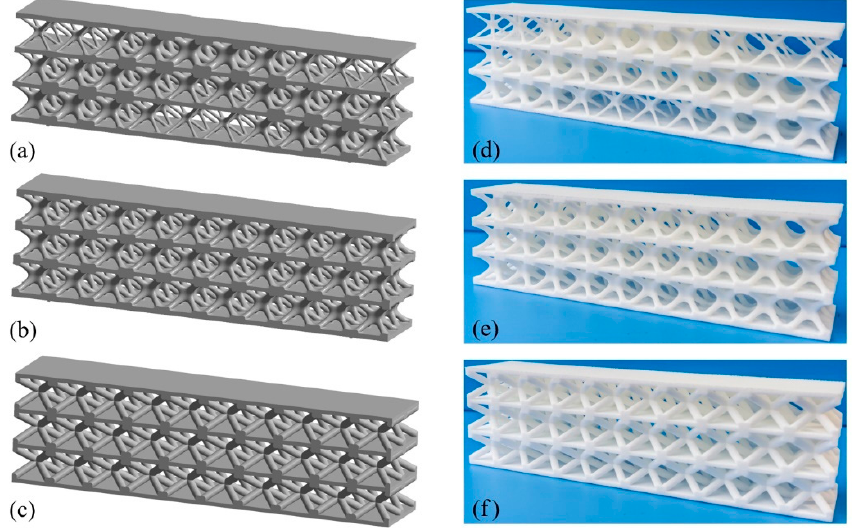
Figure 20. CAD models and printed structures of the test samples. ( a ) CAD model of optimized GLSS. ( b ) CAD model of LSS with uniform I-WP TPMS. ( c ) CAD model of LSS with uniform BCC unit cells. ( d ) Printed sample of ( a ). ( e ) Printed sample of ( b ). ( f ) Printed sample of ( c ).